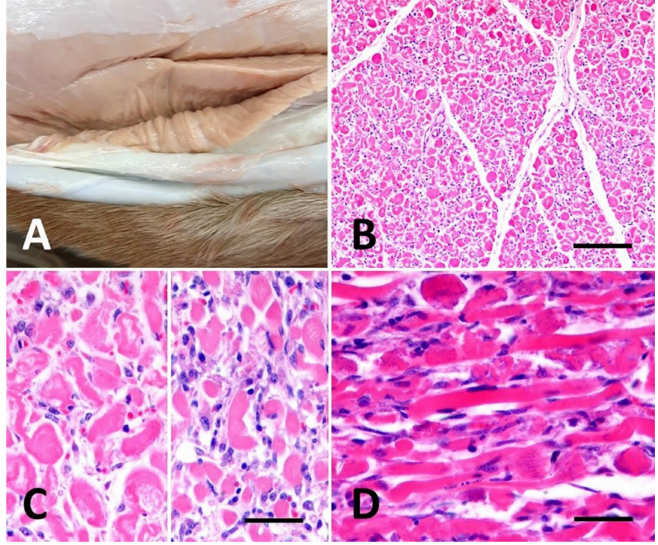
Figure 1. Gluteus muscle, case 2. ( A ) Grossly, severe pale pink discoloration on cut section. ( B ) Histological cross sections of skeletal muscle. Hematoxylin & eosin (H&E). At low power, marked fragmentation, swelling and degeneration of skeletal muscle fibers and infiltration by small dark cells (identified at higher magnification as proliferating satellite cells) were observed. Scale bar, 500 µ m; ( C ) At higher magnification, a cross section showing lysis and degeneration of myofibers (left), proliferating satellite cells and infiltrations of macrophages (right). Scale bar, 200 µ m; ( D ) longitudinal section showing severe muscle fiber degeneration and multifocal mineralization. Scale bar, 100 µ